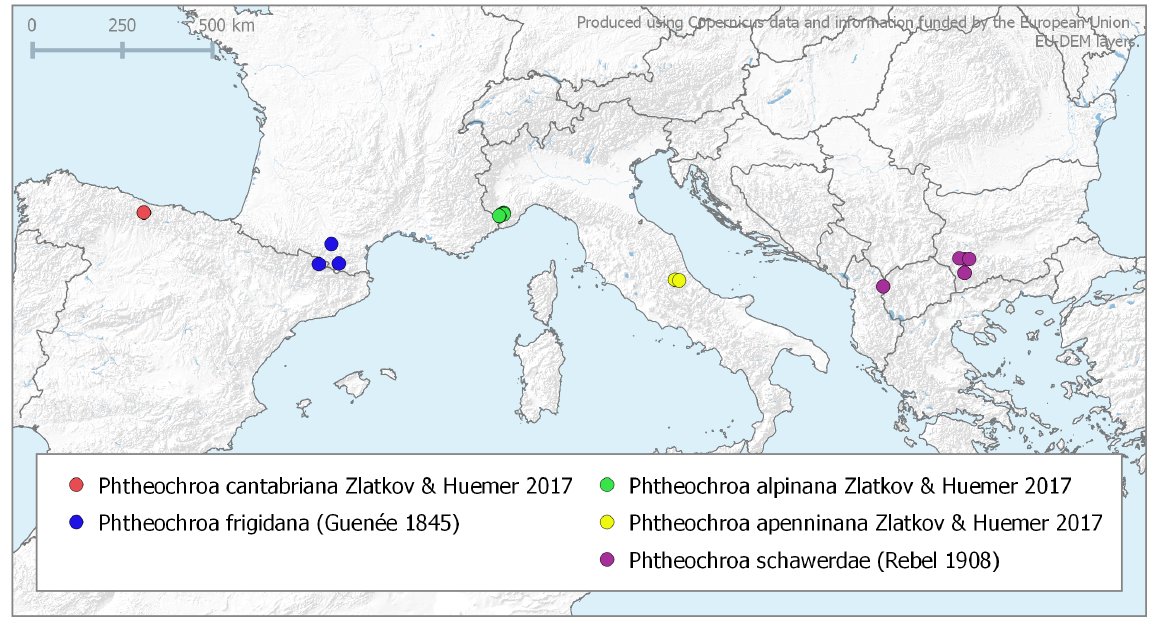
Fig. 10. Distribution of the Phtheochroa frigidana s. lat. species complex based on examined